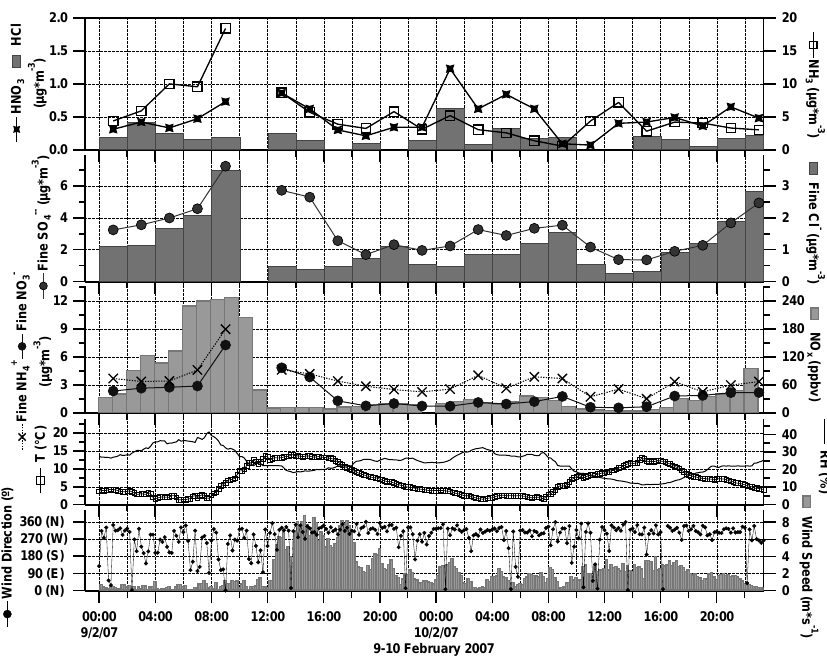
Fig. 8. Diurnal trends of fine particulate Cl − , NO −